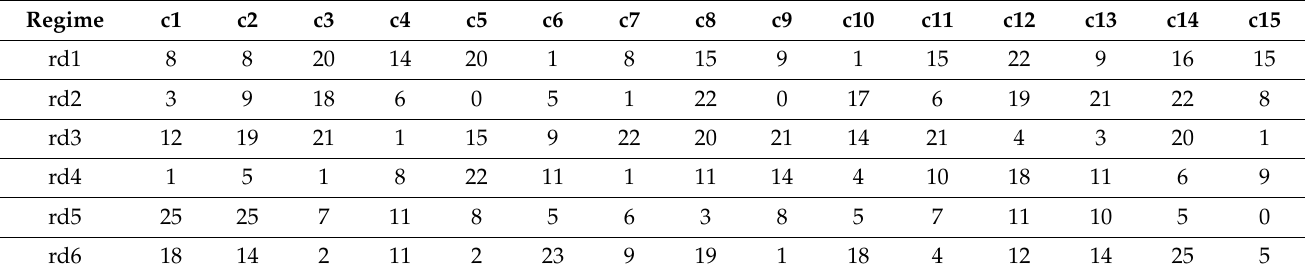
Table 7. Weight-regimes rd1 to rd6.